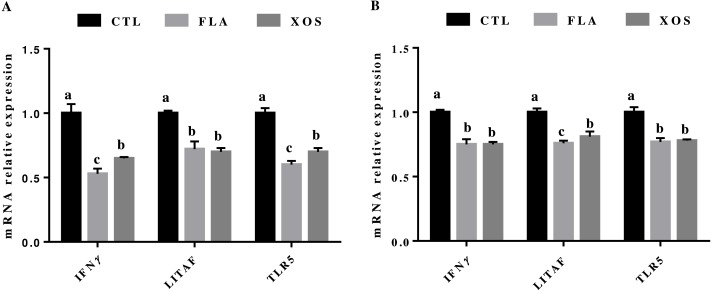
The relative mRNA expression of immune genes in the jejunal tissues of broiler chickens.IFNγ, LITAF and TLR5 mRNA relative expressions collected on 21 (A) and 42 (B) days of age. In the same row, values with no superscript letter or the same superscript letter are not significantly different (P > 0.05); those with different superscript letters are significantly different (P < 0.05).